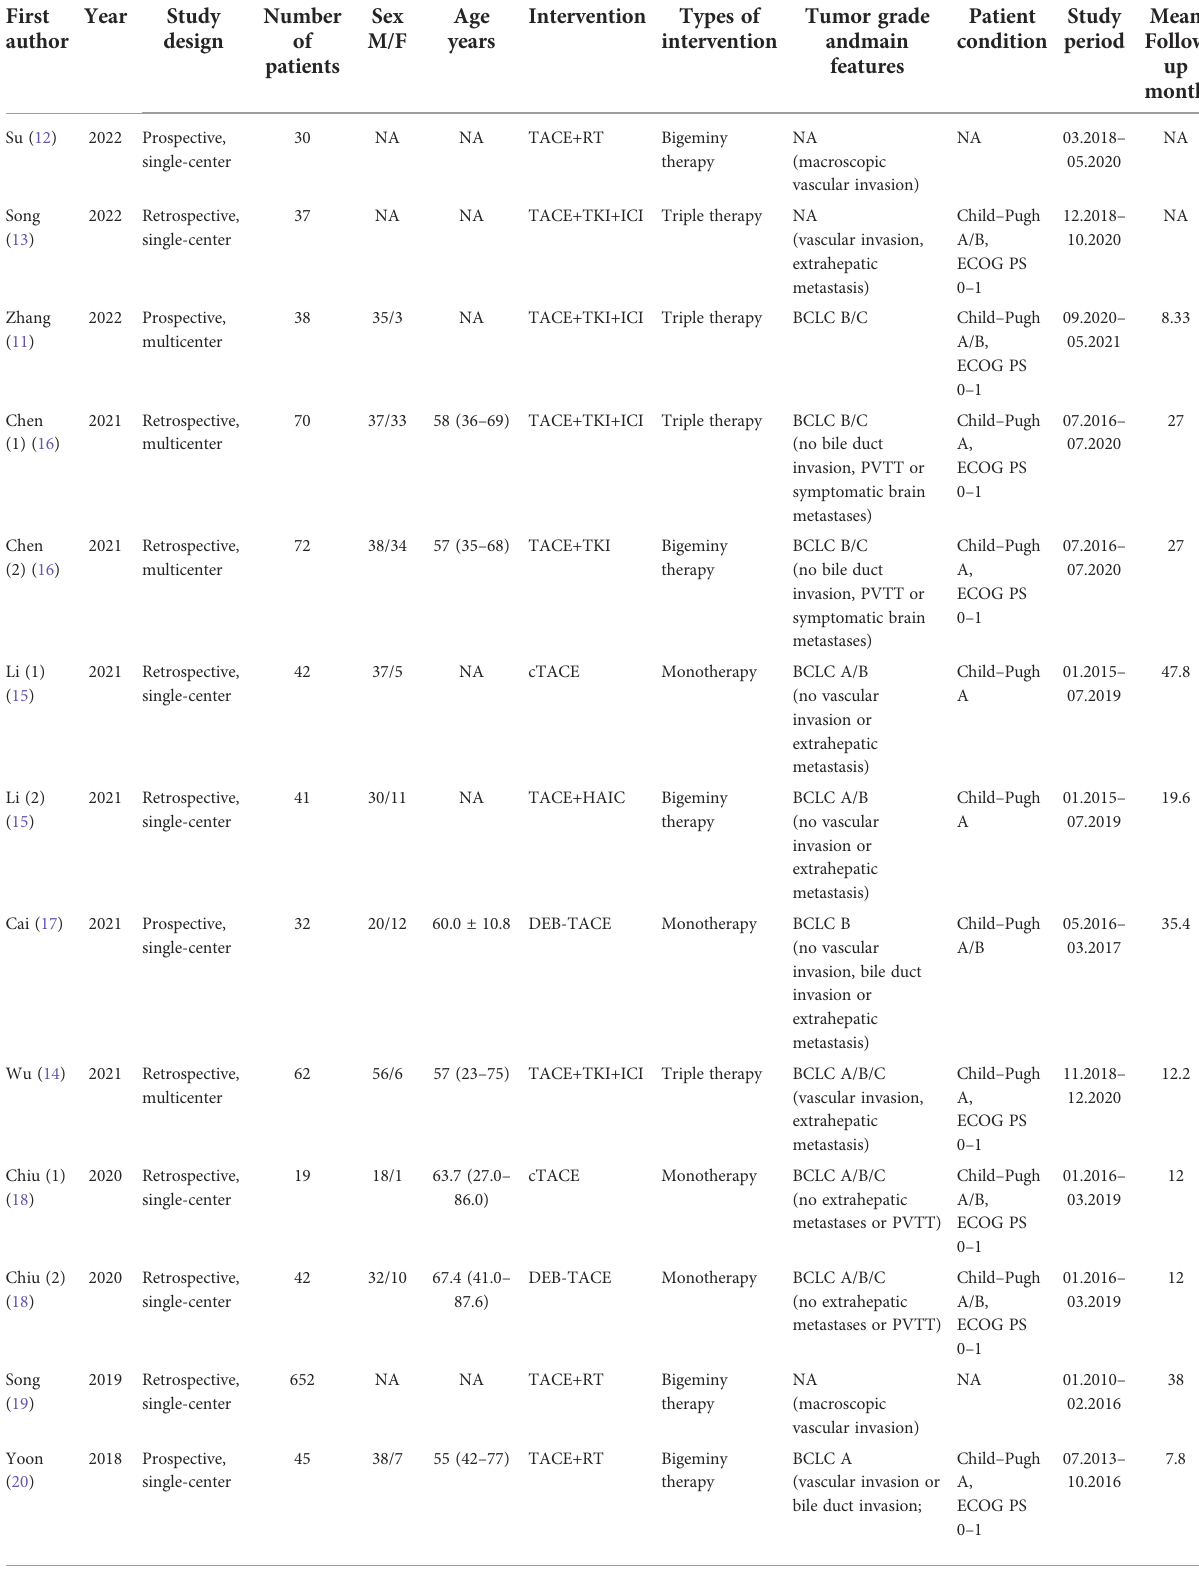
TABLE 1 Characteristics of studies selected for